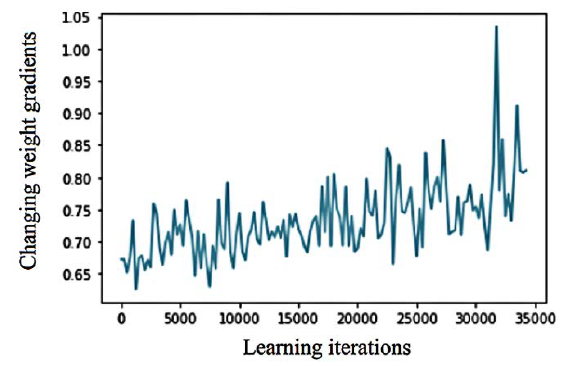
Fig. 8. Graph of the average changes in weights gradients in the first, second, and third layers of an artificial neural network